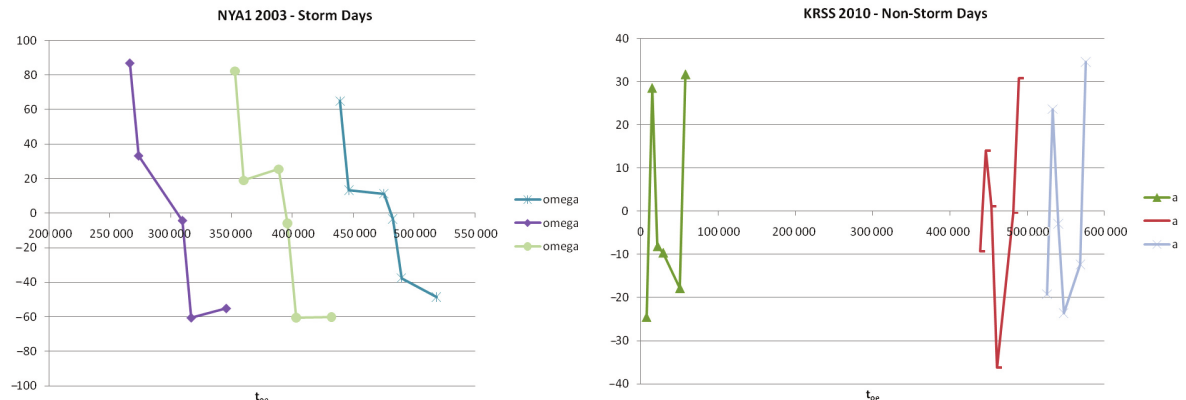
Fig. 10. argument of perigee of three stormy days in 2003 using cPOS stations (NYa1)